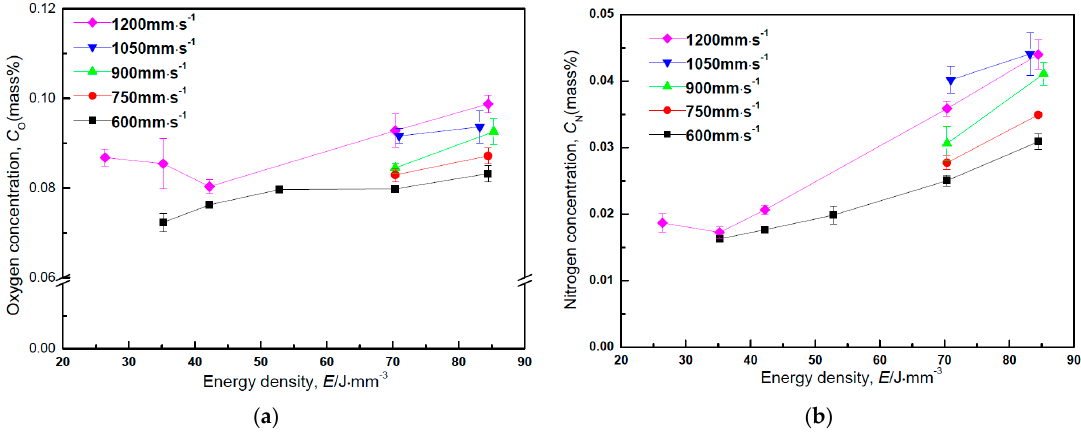
Figure 12. ( a ) The oxygen concentrations of the as-built Zr-1Mo alloys as a function of energy density; ( b ) The nitrogen concentrations of the as-built Zr-1Mo alloys as a function of energy density.